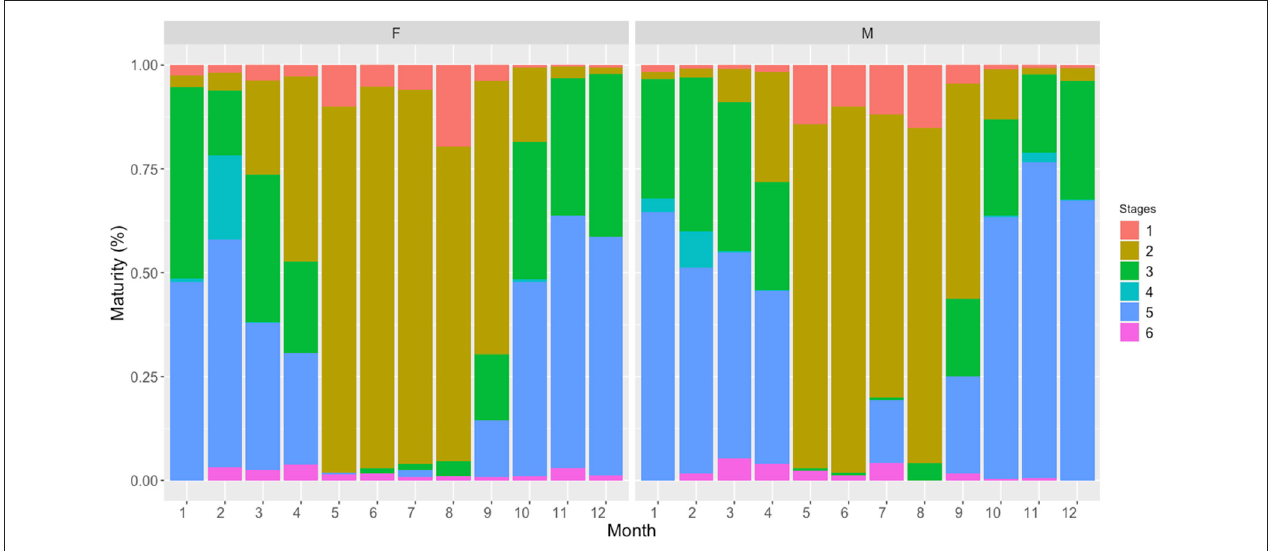
FIGURE 2 | Monthly evolution of gonadic maturity stages pooling the whole study period for female (F) and male (M) European